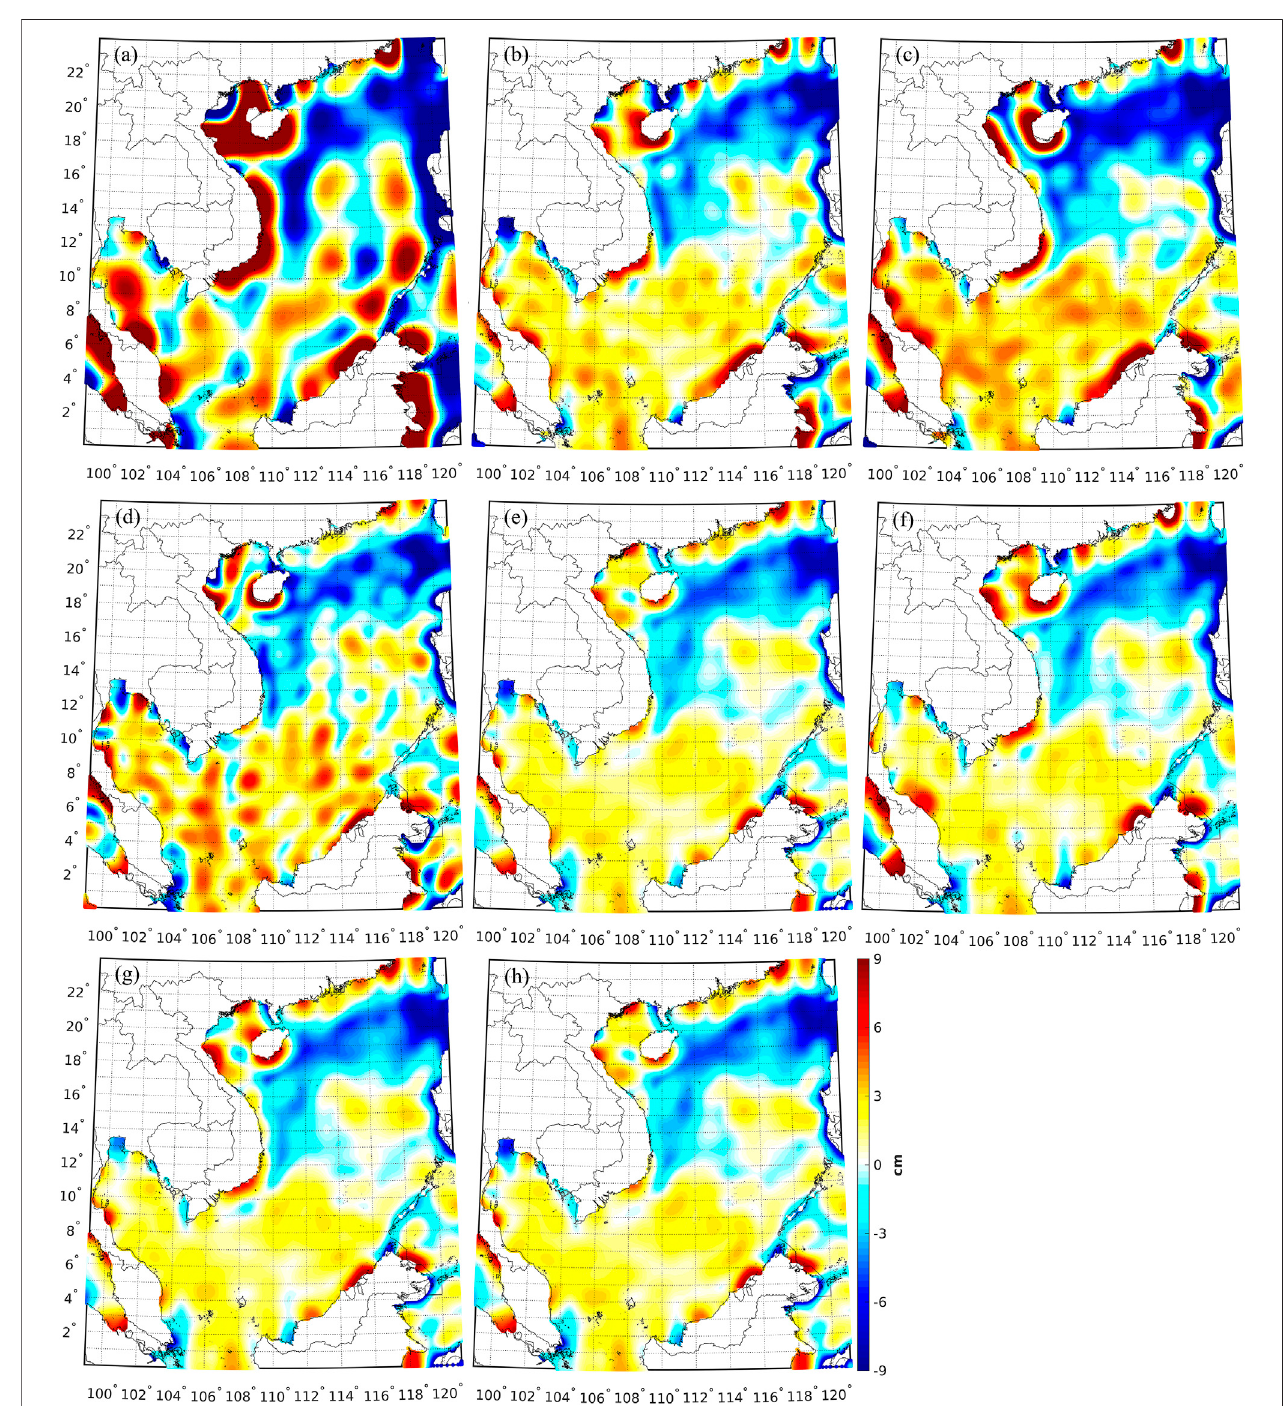
FIGURE8| Differences between theMDT computed from (A) EGM2008, (B) GECO, (C) SGG-UGM-1, (D) EIGEN-6C4, (E) XGM2019e_2159, (F) GOCO05c, (G) XGM2016, (H) XGM2019 and mean value of all synthetic/ocean models.